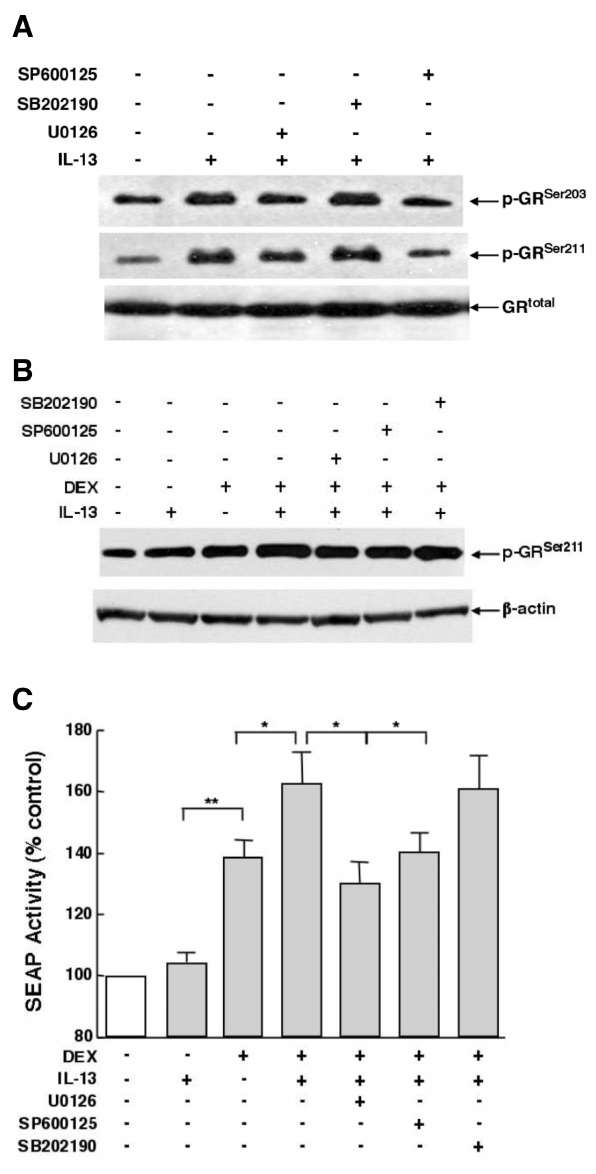
Figure 6. GR phosphorylation by IL-13 and its induction of heightened DEX-stimulated GR Ser211 phosphorylation and transactivation are suppressed by inhibition of ERK1/2 and JNK signaling. ( A ) Representative immunoblots from one of three experiments demonstrating that IL-13-induced maximal GR Ser203 and GR Ser211 phosphorylation elicited at 3 and 12 h, respectively, are suppressed in HASM cells pretreated with either the ERK1/2 or JNK inhibitors, U0125 and SP600125, respectively, whereas pretreatment with the p38 MAPK inhiobitor, SB202190, has no appreciable effect. Comarably, heightened DEX-stimulated GR Ser211 phosphorylation (B) and transactivation of SEAP activity (C) exhibited in IL-13-exposed HASM cells are suppressed by pretreatment with the ERK1/2 and JNK inhibitors, whereas the p38 MAPK inhiobitor has no effect. Data are mean 6 SE values from 4 experiments (*p , 0.05; **p ,